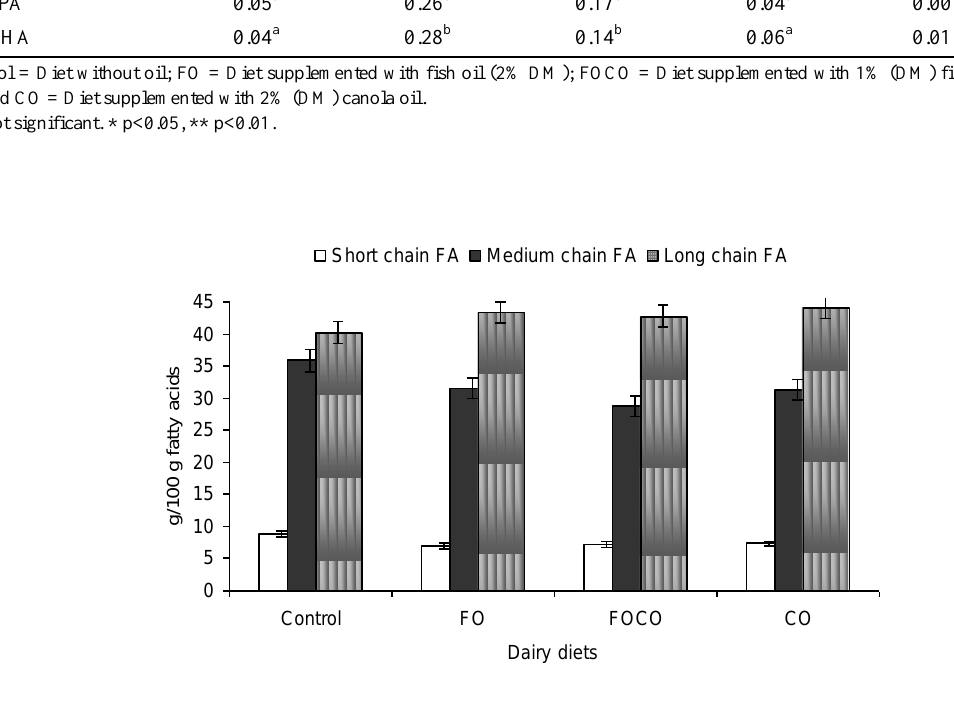
Table 4. Milk fatty acid content (g/100 g fatty acid) of dairy cows fed diets containing fish and canola oil Fatty acids